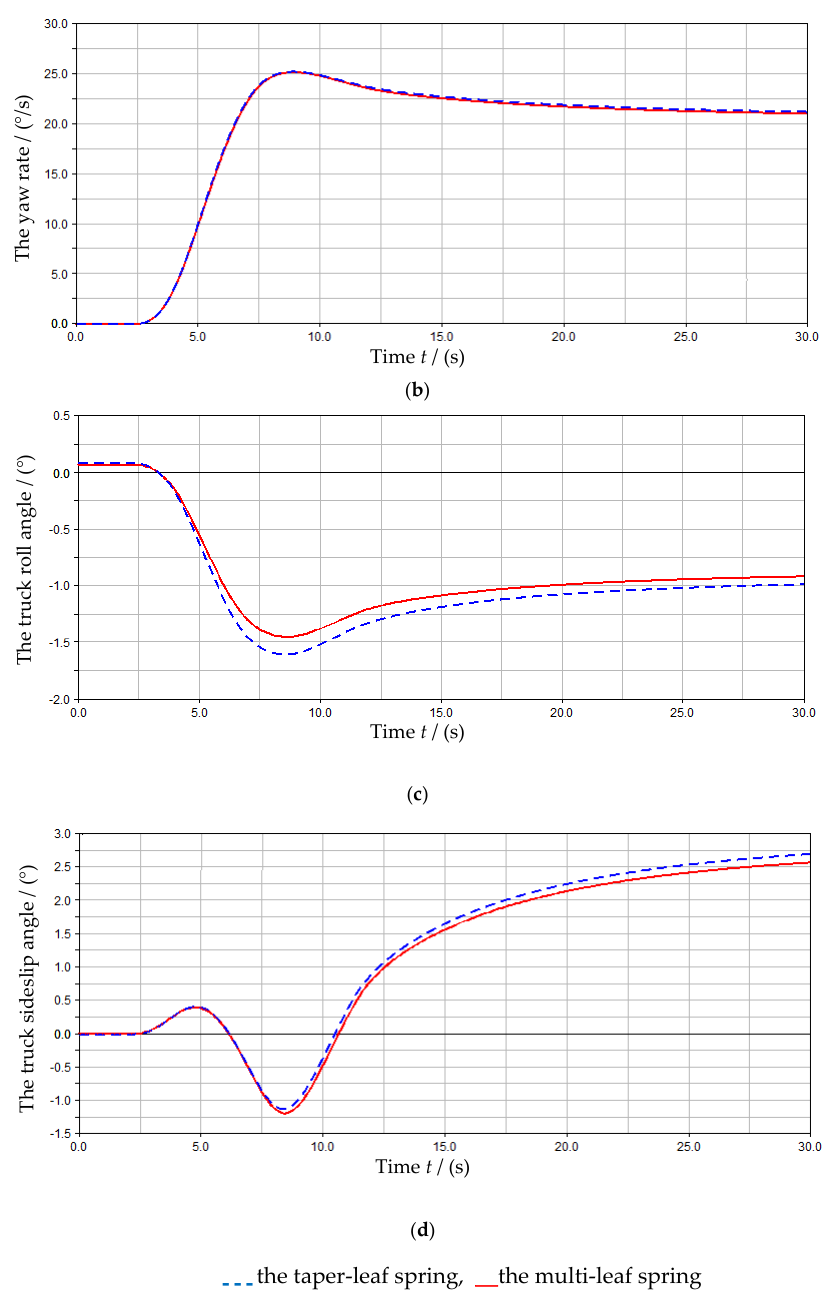
Figure 14. A comparison of the simulated dynamic responses obtained from the step steer tests: ( a )